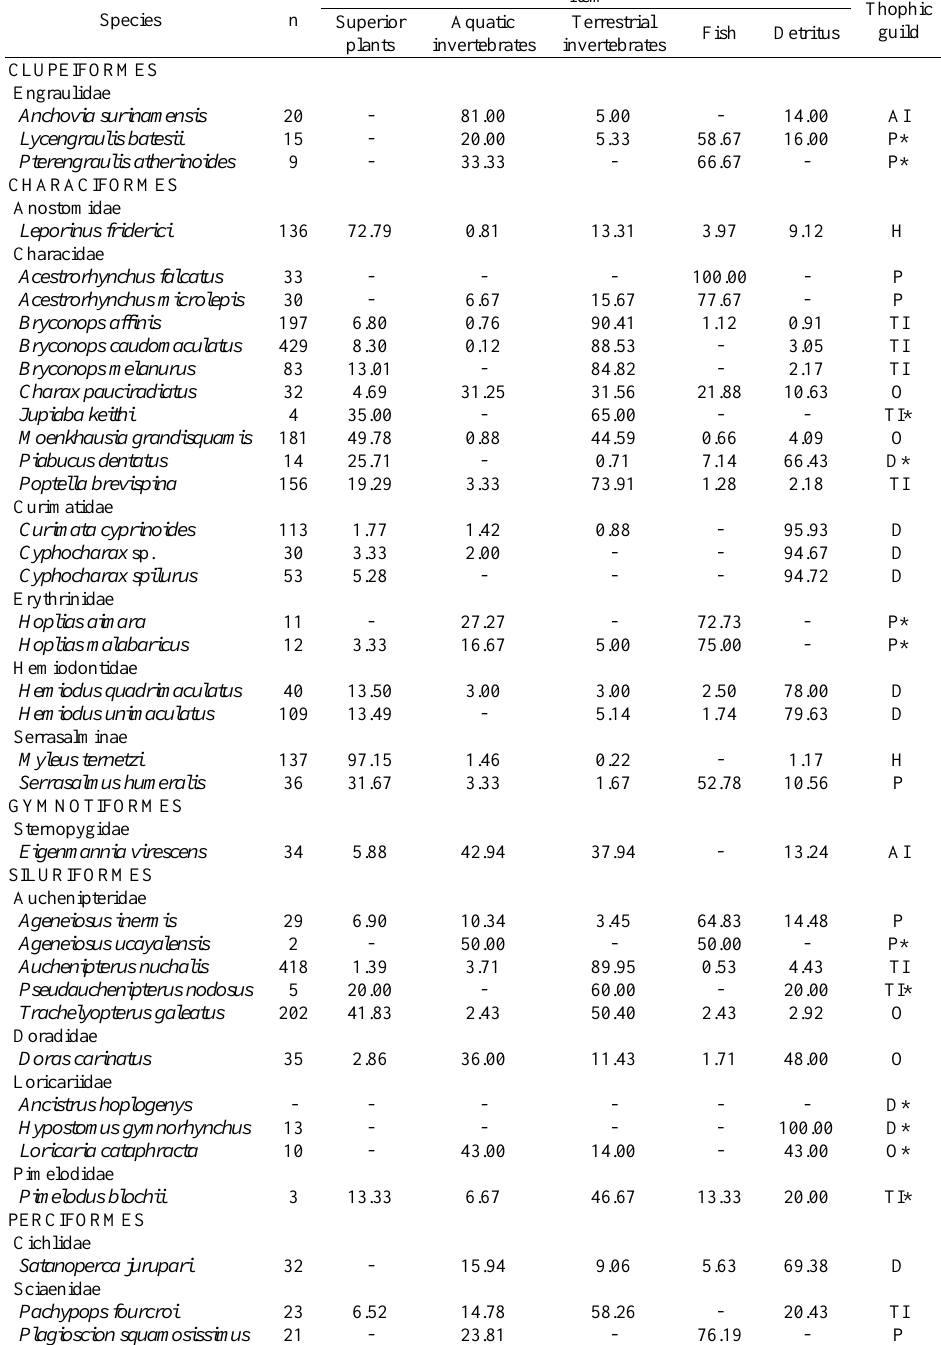
Table 2. Number of stomachs analyzed (n), percentage of alimentary items found and trophic guild by fish species. * = trophic guild confirmed by literature; D = Detritivores; AI = Aquatic invertivores; H = Herbivores; O = Omnivores; P = Piscivores; TI = Terrestrial